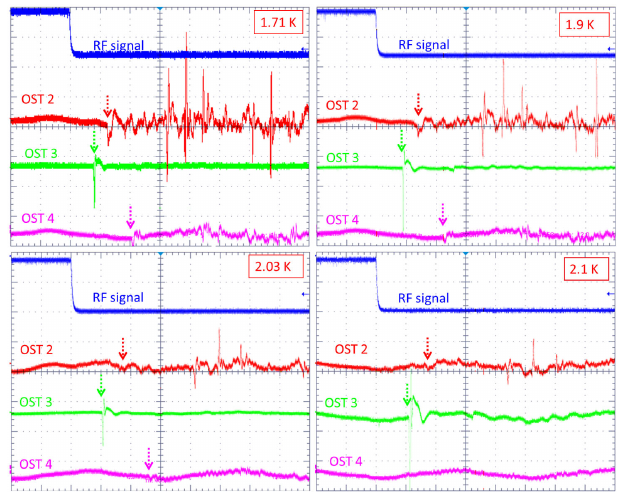
FIG. 5. Times of arrival of the 2nd sound signal on the two closest OSTs from the quench location at 1.7 K: as measured during experiment (Red) and as calculated with in direct line of sight (Blue).